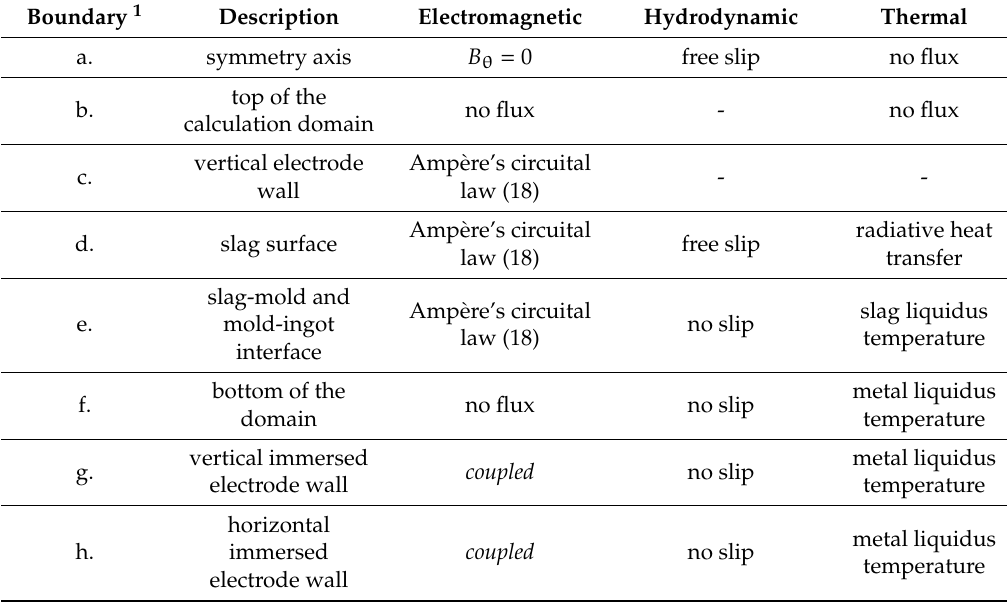
Table 2. Summary of the boundary conditions.